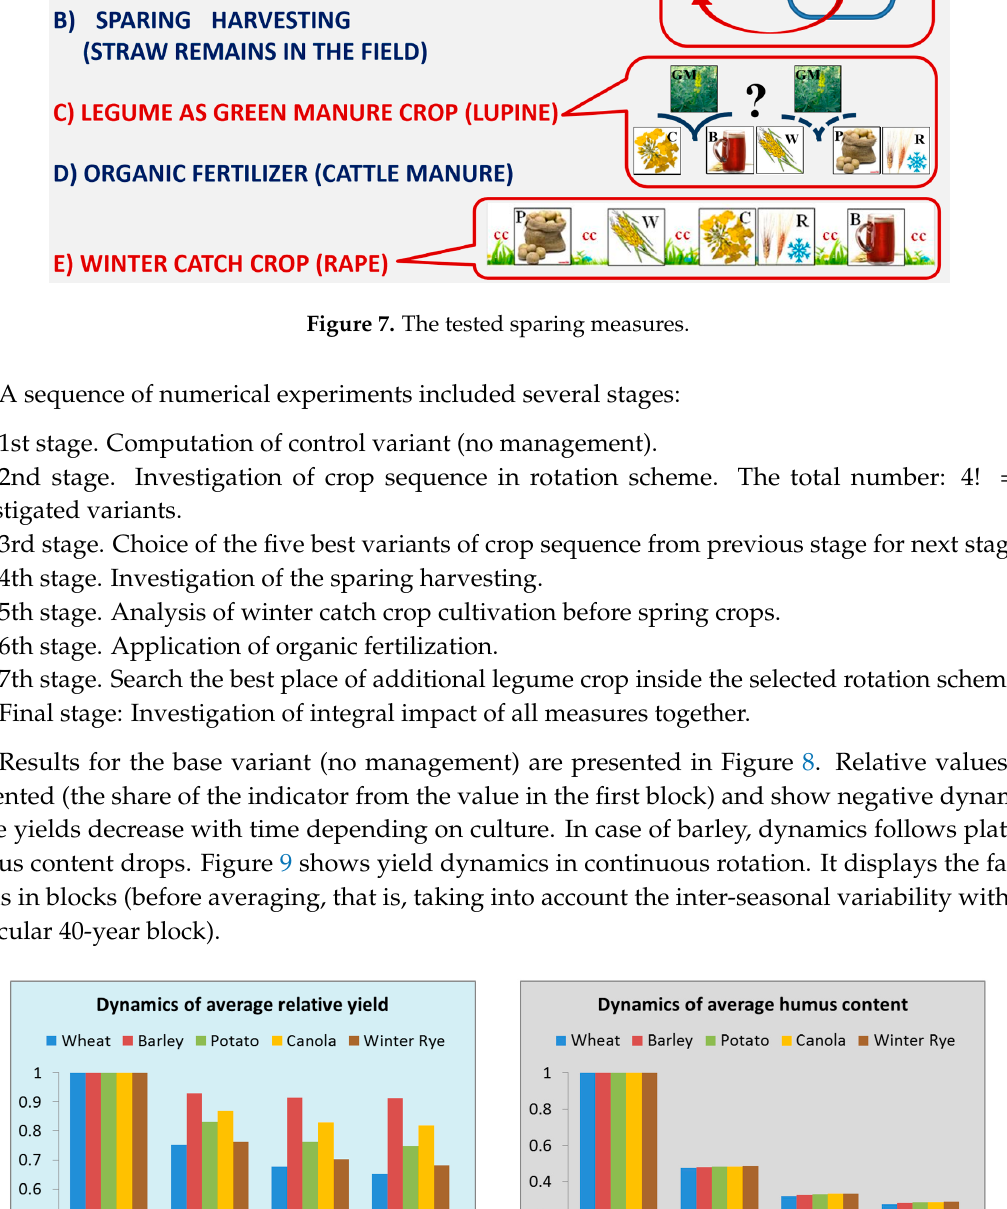
Figure 8. Results for base variant (no management): ( a ) Dynamics of average relative yield; ( b )